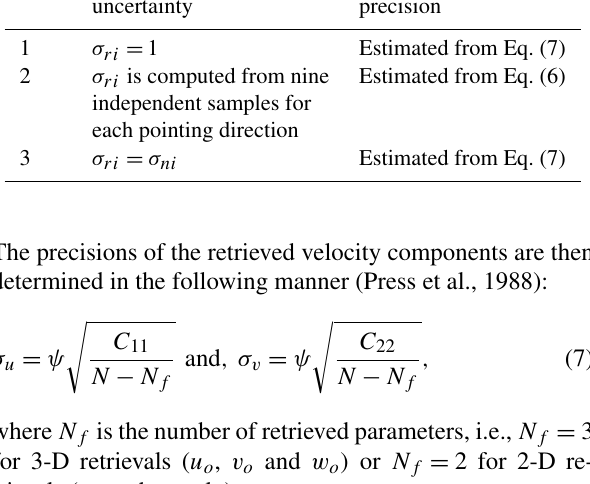
Table 1. Radial velocity and retrieved parameter precision estima- tion schemes for trials 1, 2 and 3. Trial Radial velocity Retrieved parameter uncertainty Estimated from Eq.